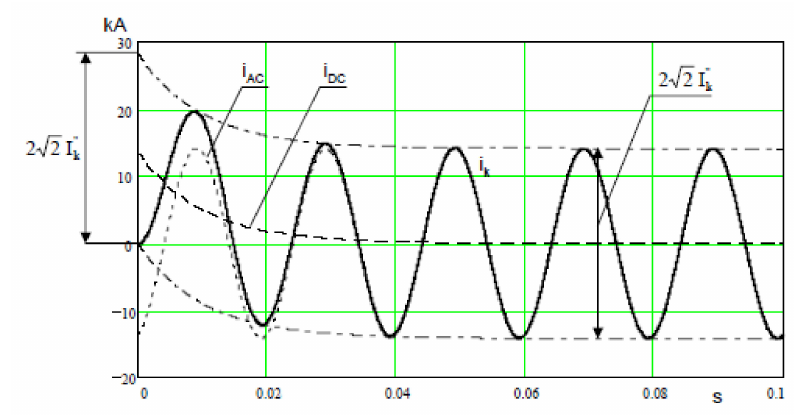
Figure 18. An example of the prospective short circuit current waveform at a remote short circuit in a low-voltage circuit, i AC —periodic component, i DC —non-periodic component, i k —peak current